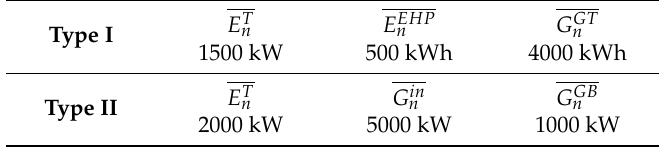
Table 2. Parameters of the devices in the smart energy